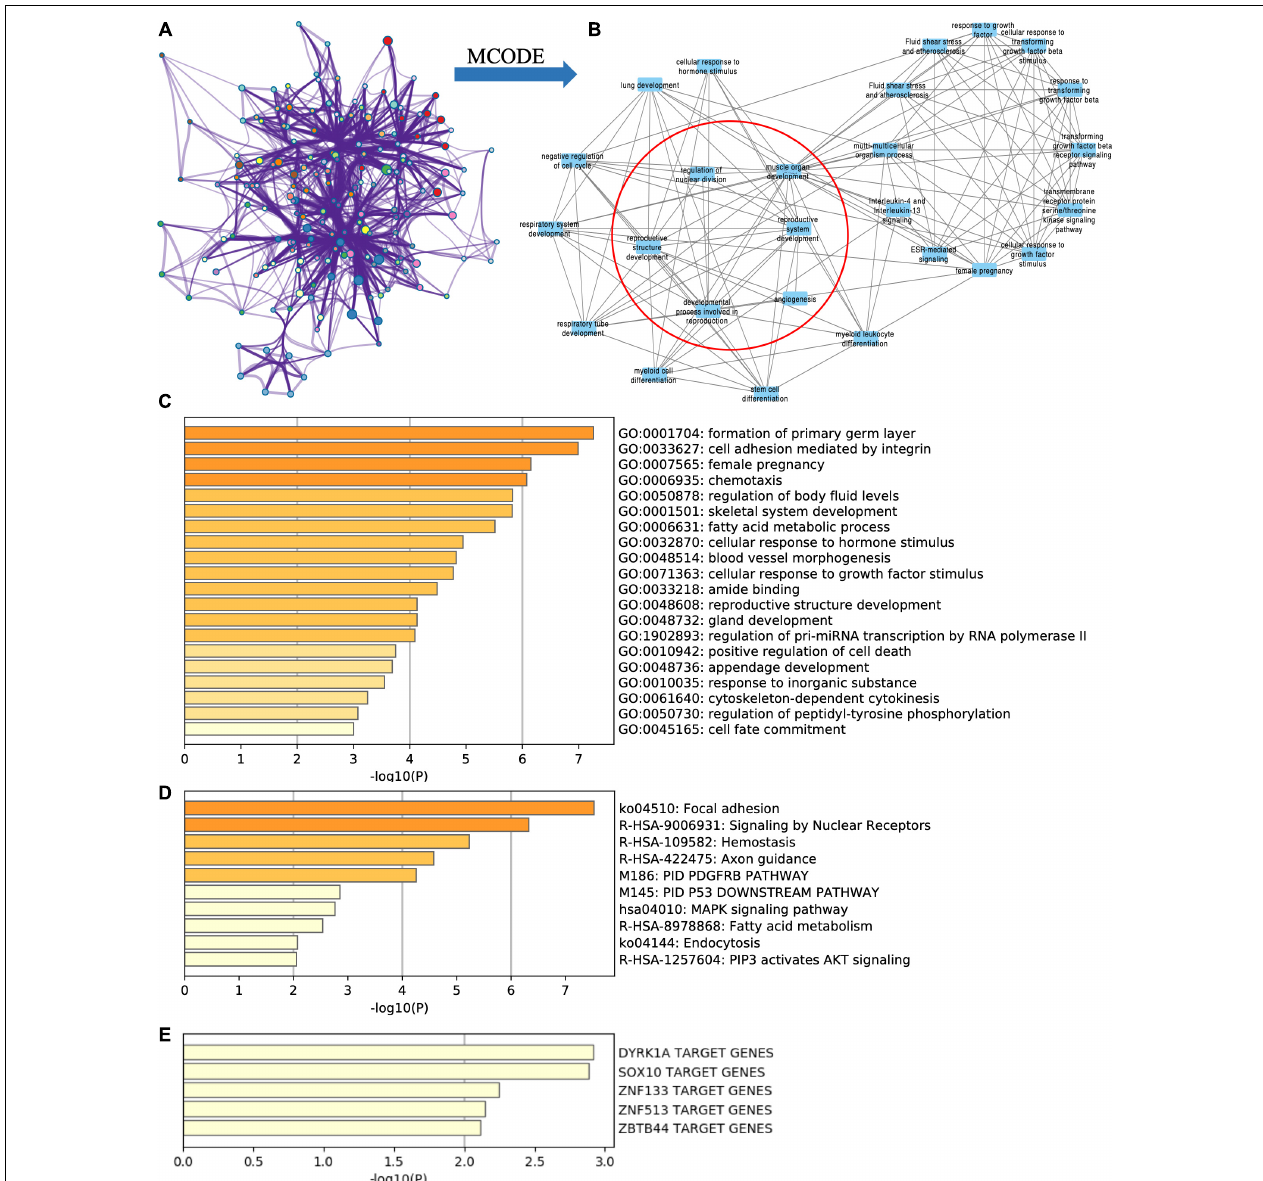
FIGURE 4 | Functional enrichment analysis of targeted DE mRNAs of GSE71331/71332. (A) The network of functional terms. (B) The key module network selected by MCODE (inside the red circle) and first neighbor node of the key module network (outside the red circle). (C) The enriched GO terms of targeted DE mRNAs. (D) The enriched pathway of targeted DE mRNAs. (E) The transcription factors related to targeted DE mRNAs.